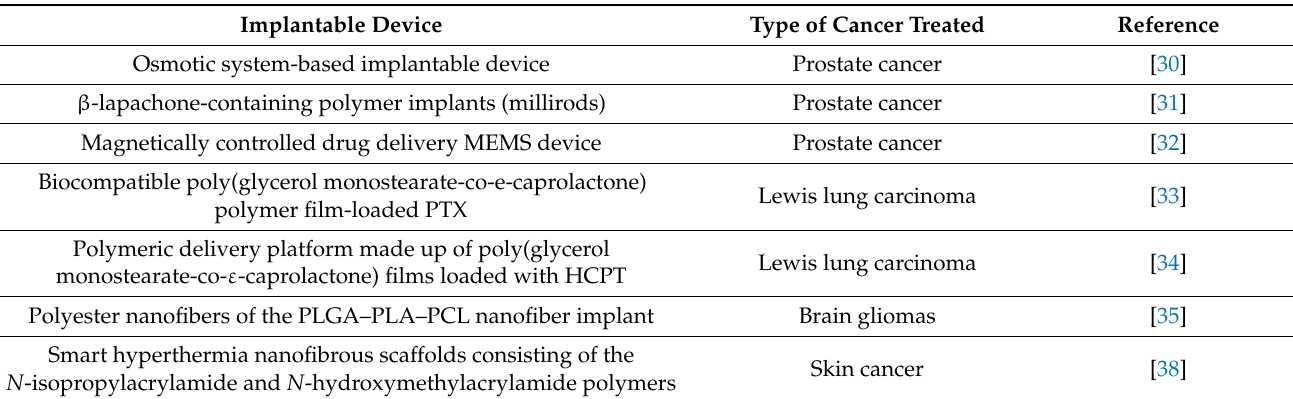
Table 1. Implantable devices for cancer